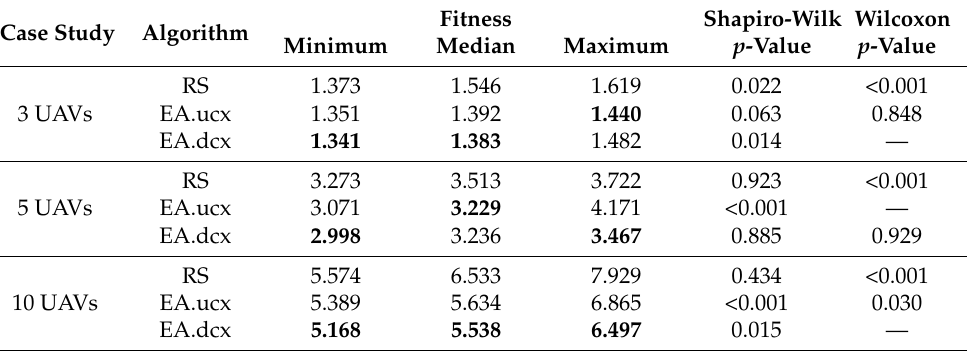
Table 3. Results of the optimisation process comparing RS and EA (10 scenarios). Best results are in